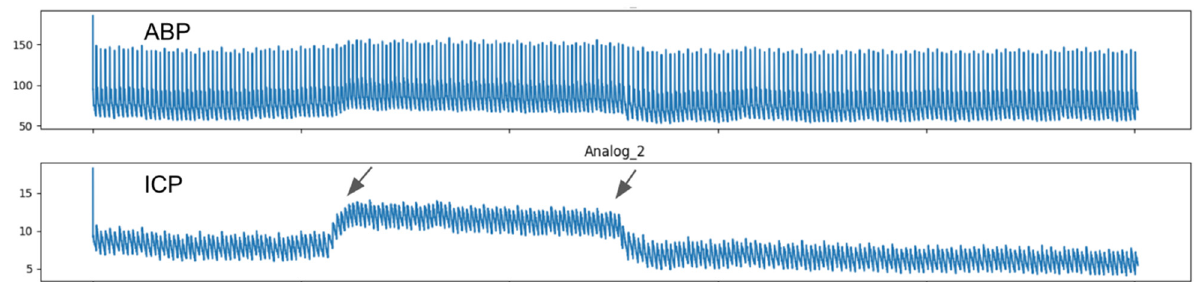
Figure 3. Mean ICP, P2/P1, TTP and pulse amplitude were calculated and correlated between baseline and 60 s IJV compression (plateau between arrows) intervals.